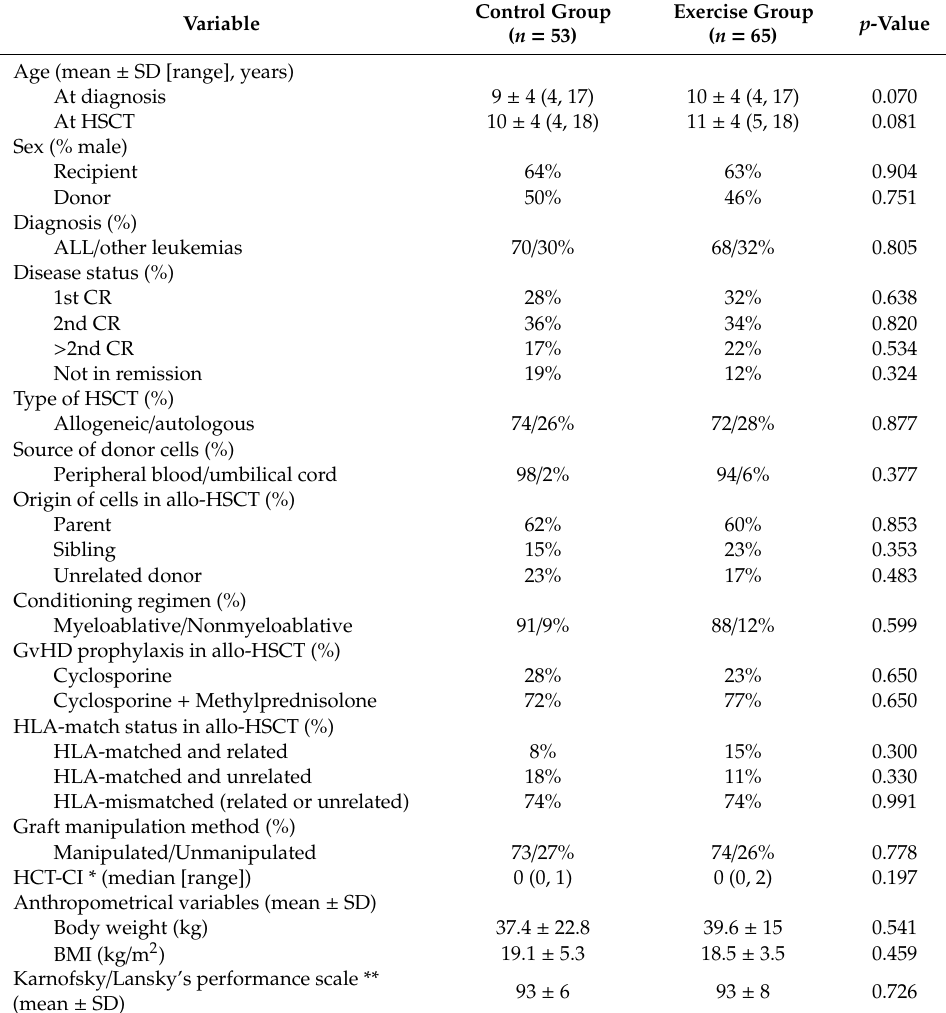
Table 1. Main demographic and clinical characteristics by